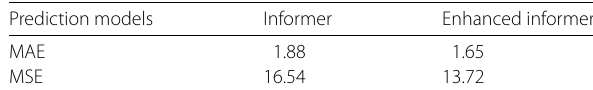
Prediction models